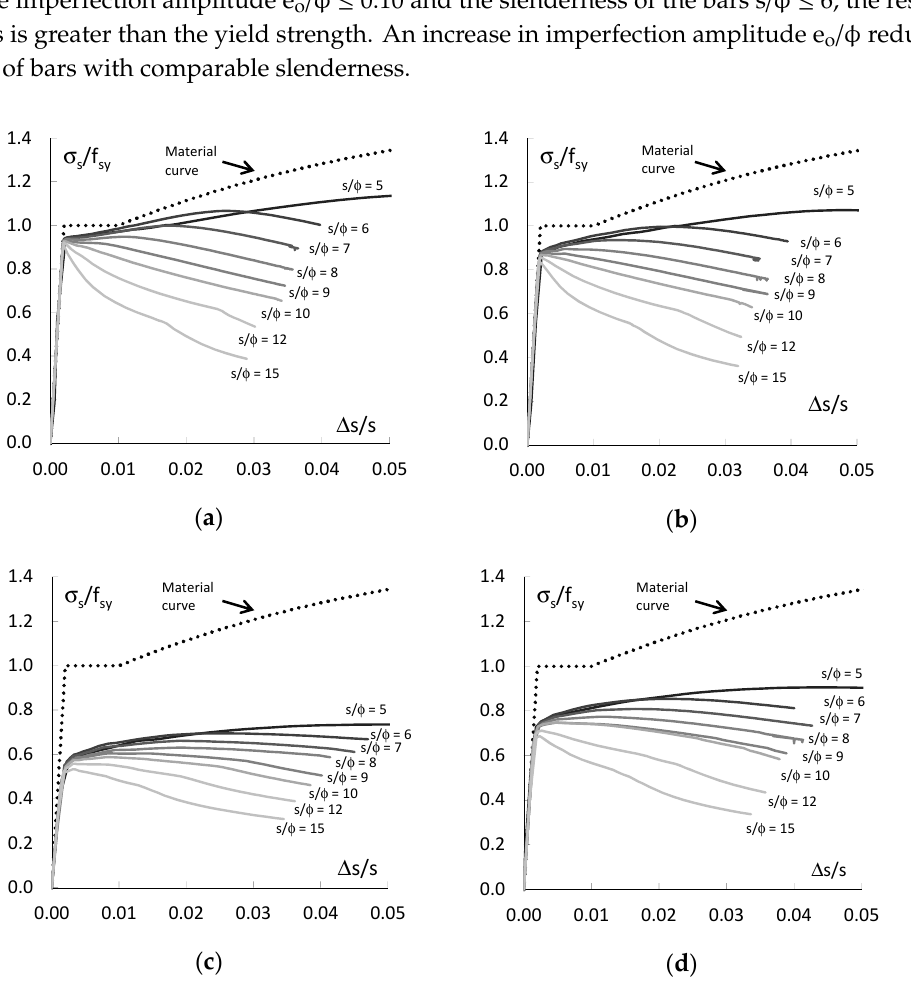
Figure 5. Normalized s tress—strain curve for MD bars: ( a ) e/ ϕ = 0.05, ( b ) e/ ϕ = 0.10, ( c ) e/ ϕ = 0.25 and ( d ) e/ ϕ = 0.50.